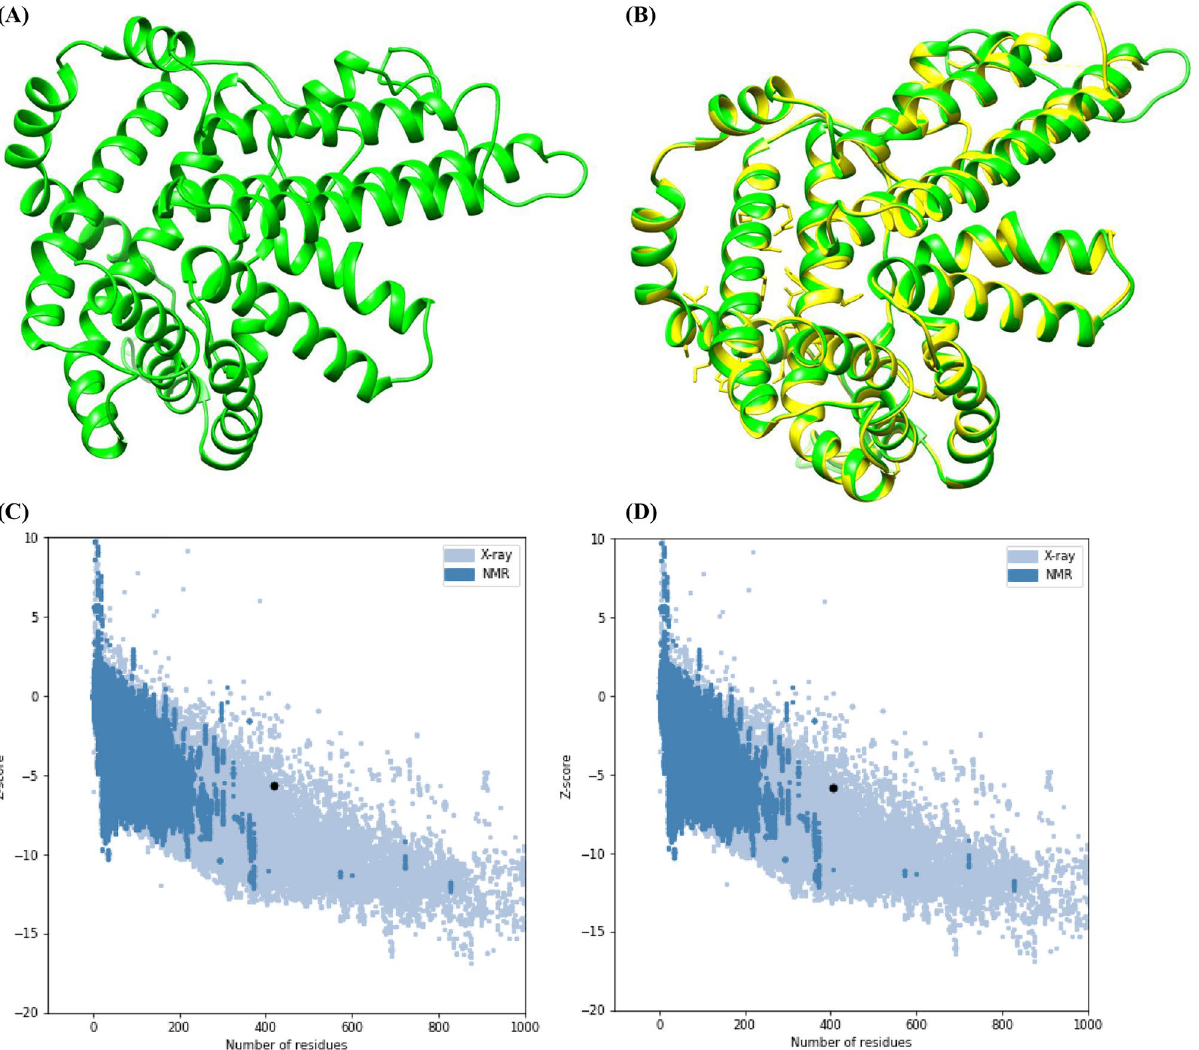
Figure 2. ( A ) 3D model of DGAT1. ( B ) Superimposed structure of DGAT1 with its template structure 6VYI_A. ( C ) Overall quality of DGAT1 model depicting a z-score of –5.63 (Native conformation to its template). ( D ) Overall quality of template (6VYI_A) depicting a z-score of